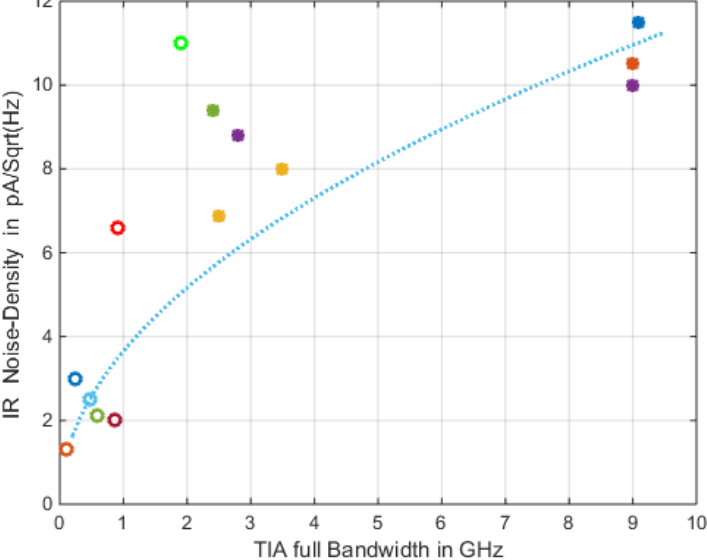
Figure A2. Input-referred current noise densities for several commercial transimpedance amplifiers from the data sheets. Circles represent housed ICs, while filled dots are for bonded dies. Dotted blue trend line follows B 0.5 .